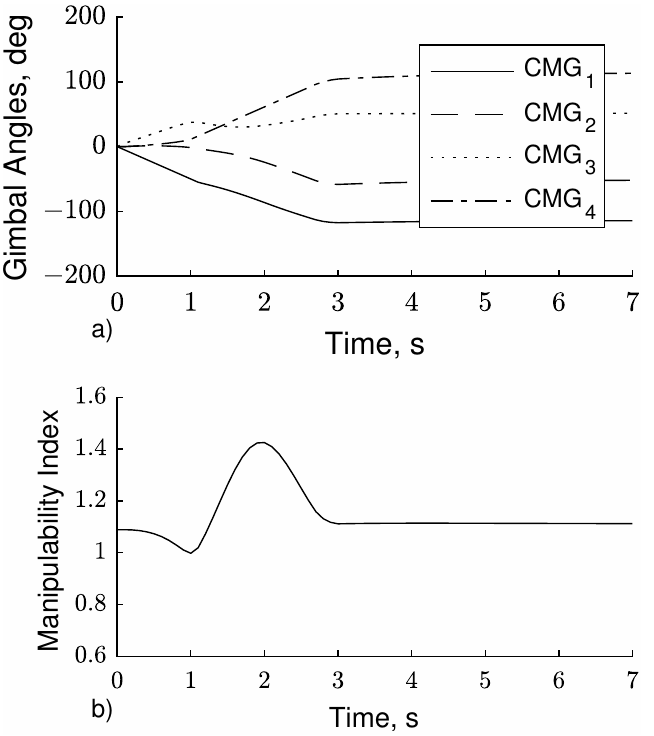
Figure 11. Simulation results with RFC—2nd approach. ( a ) Gimbal angles, ( b ) Manipulability index. Similarly to most ML techniques, the derivation of the data-set and the training of the model can be done offline without being involved in the operation of the system. Thus, a total time comparison between the NSP and the ML techniques would be unfair. In order to measure the execution time difference, i.e the time it takes for all the calculations